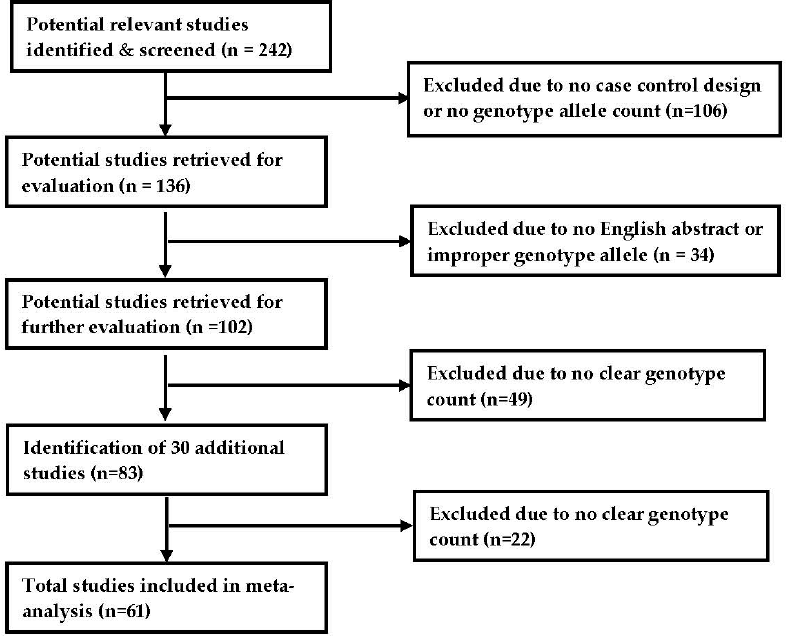
Figure 1. Progression of the selection of studies for the meta ‐ analysis.